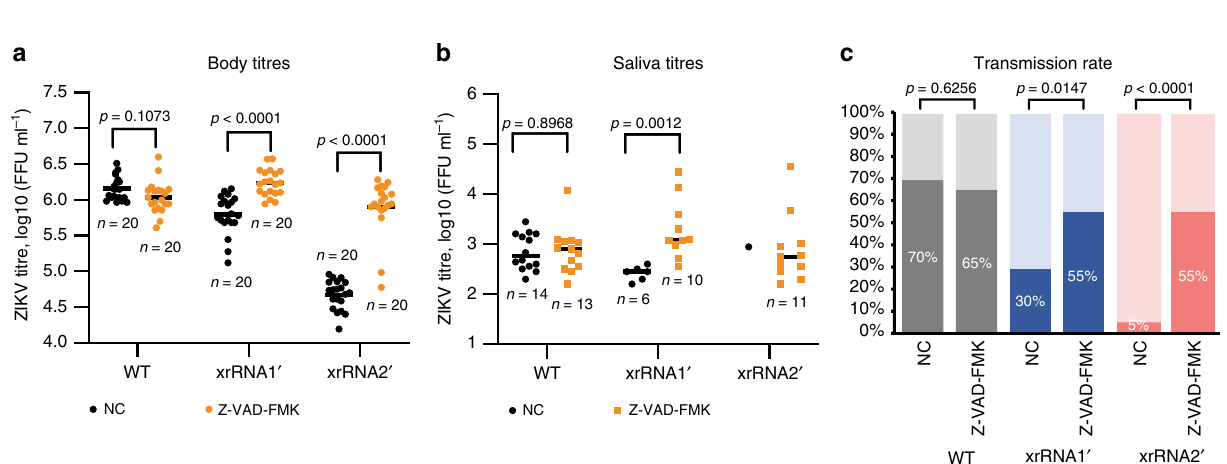
Fig. 6 Effect of caspase inhibitor on in vivo replication and transmission of ZIKV. Mosquitoes were i.t. injected with 200 nl of inoculums containing 10 4 FFU/ml of each virus either with 625 μ M of pan-caspase inhibitor Z-VAD-FMK or with vehicle control (NC). a ZIKV titres in mosquito bodies at 14 days after co-injection of viral inoculum with Z-VAD-FMK or vehicle control (NC). b Viral titres in saliva samples collected from caspase inhibitor-treated and untreated ZIKV-infected mosquitoes. c ZIKV transmission rate of WT and sf-RNA-de fi cient ZIKV by mosquitoes treated with Z-VAD-FMK or vehicle control (NC) determined as a percentage of ZIKV-positive saliva samples (darker shading on the graphs). All titres are determined by IPA on C6/36 cells. Statistical analysis is by independent Mann – Whitney U-tests (no multiple comparisons) ( a , b ) and chi-squared test ( c ). All P -values are two-sided, graphs in ( a ) and ( b ) show individual and median (horizontal lines) values, sample sizes ( n ) are indicated in the fi gure. NC, negative control